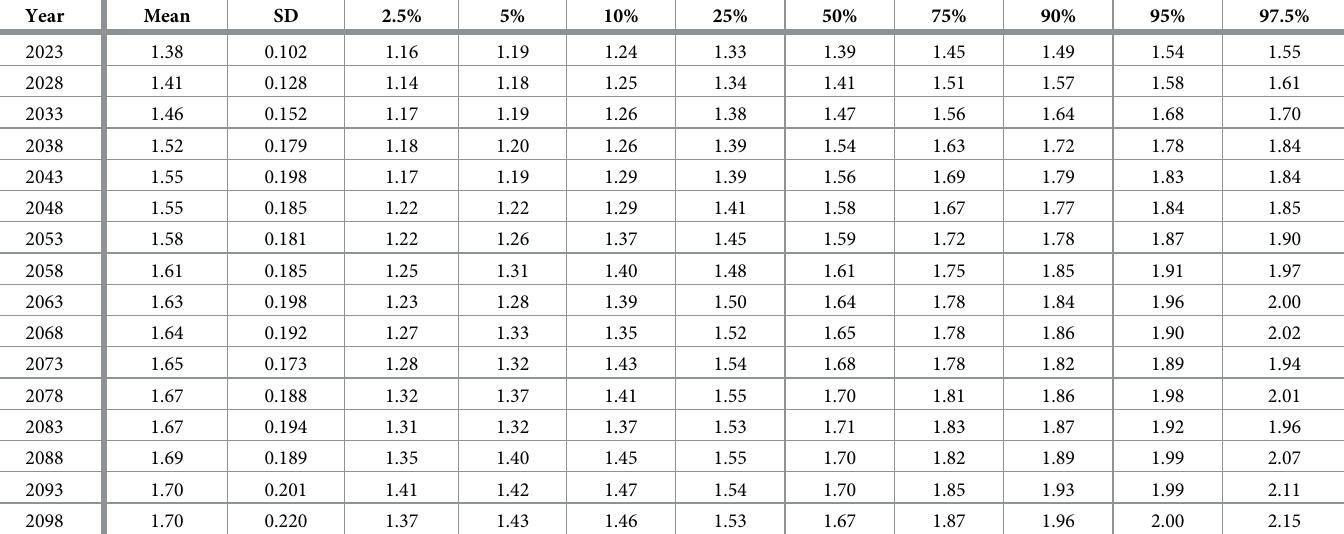
Table 3. Projected TFR simulations for